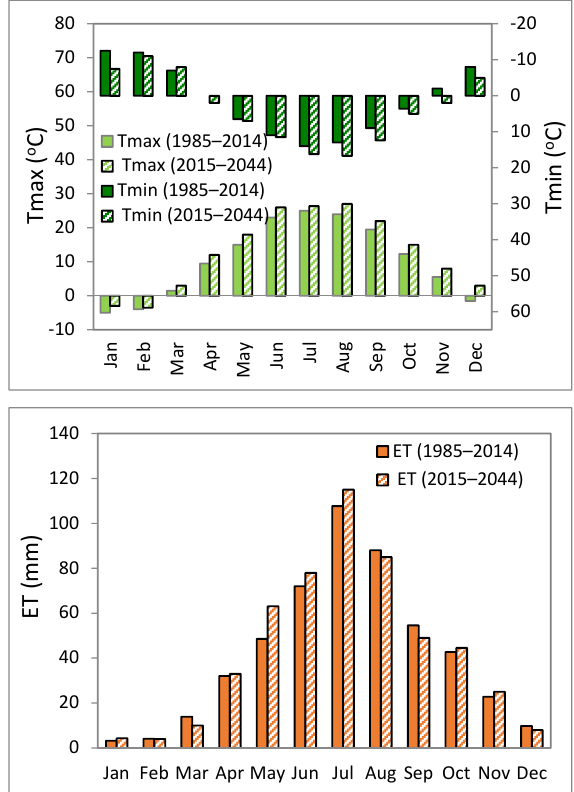
Figure 3. Historical and future predicted monthly average precipitation, temperature, and evapotranspiration. ET, Evapotranspiration; PCP, Precipitation